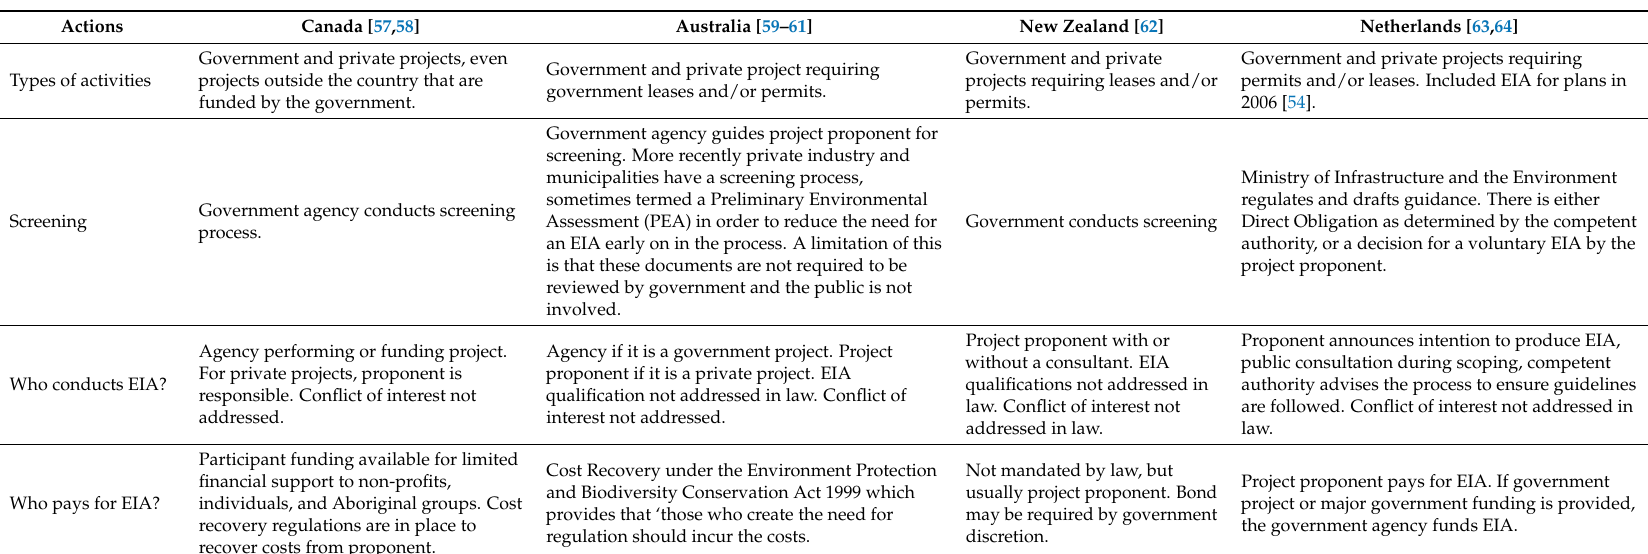
Table A2. Comparing EIA in other developed